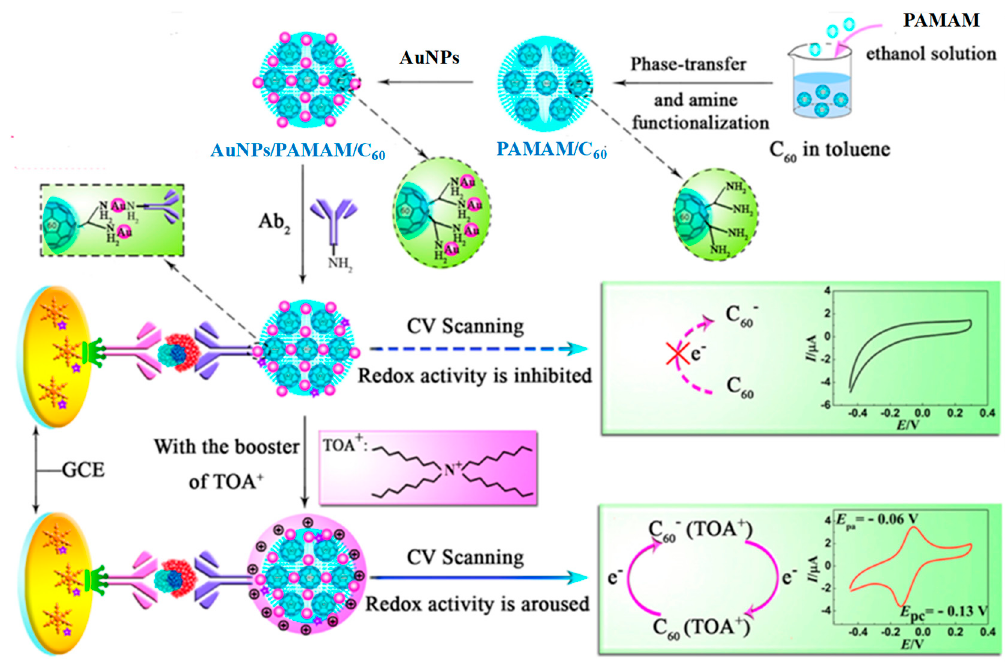
Figure 5. Scheme of the AuNPs / PAMAM / C 60 synthesis used as nanocarrier in the preparation of an immunosensor for the determination of EPO, and possible mechanism of the electrochemical reaction used to monitor the affinity reaction. Reprinted from [66], with permission.